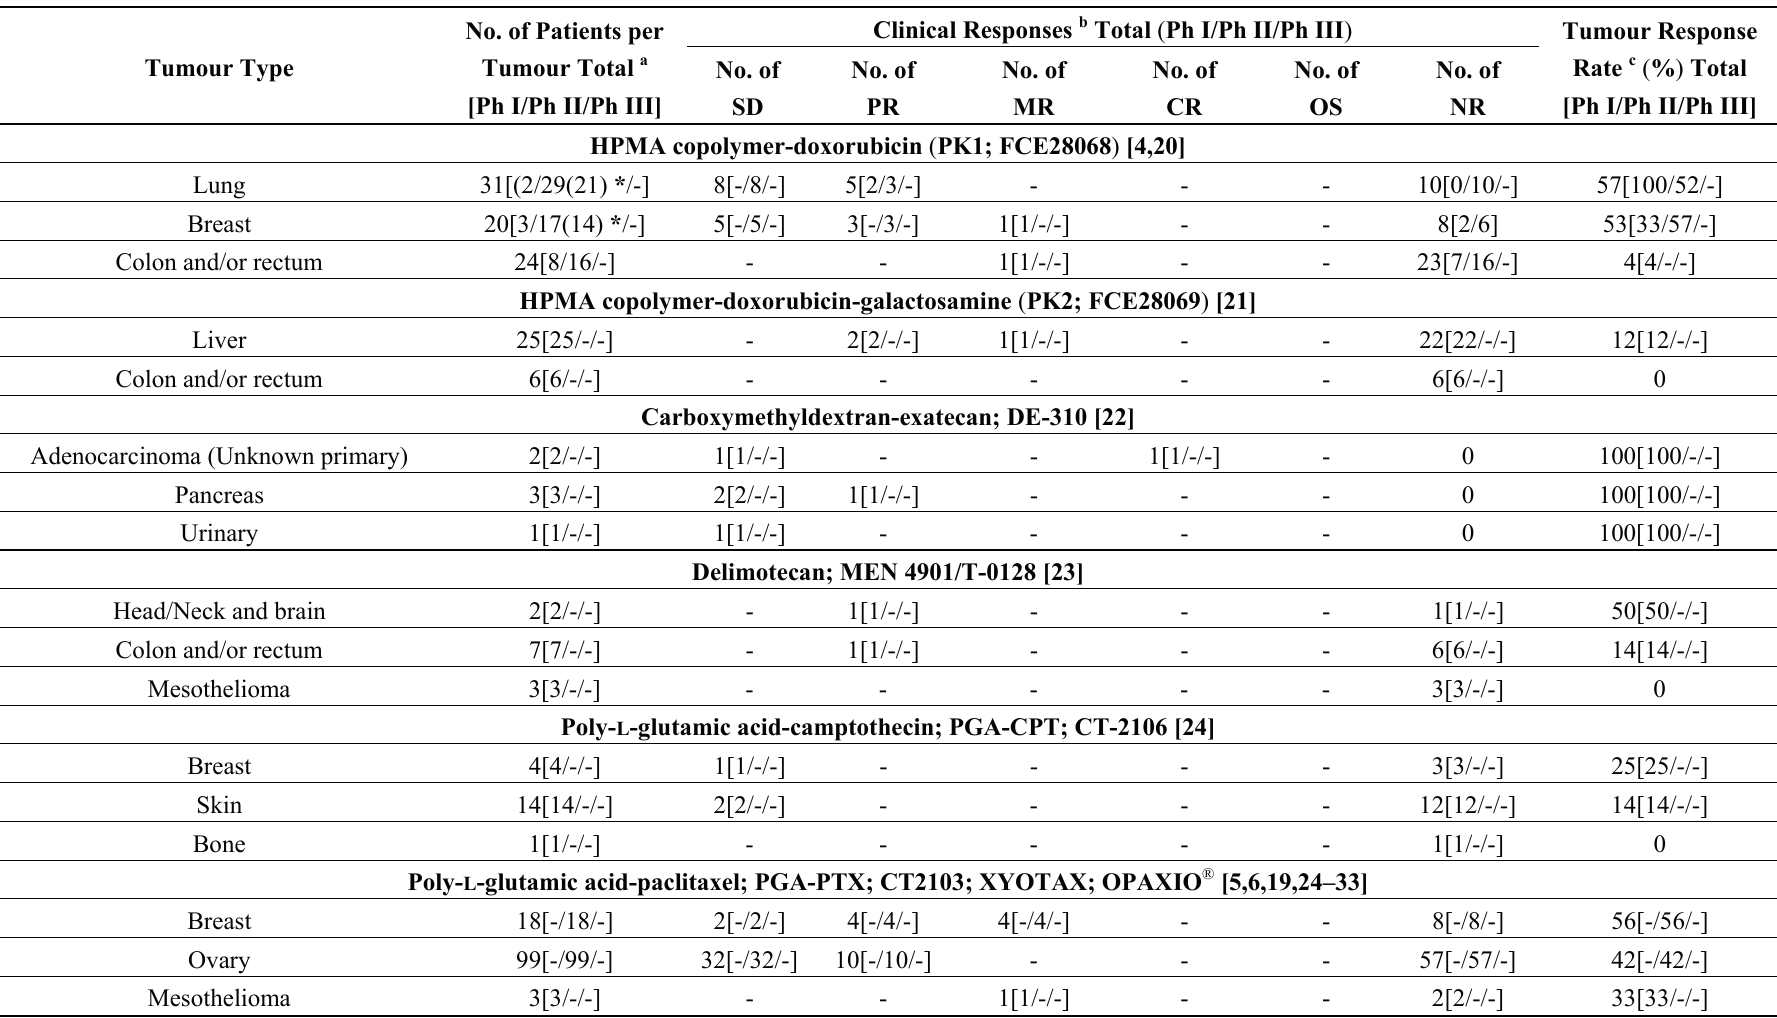
Table 3. Clinical data for the top three tumour types for the nineteen PDCs that are released by both cathepsins and change in